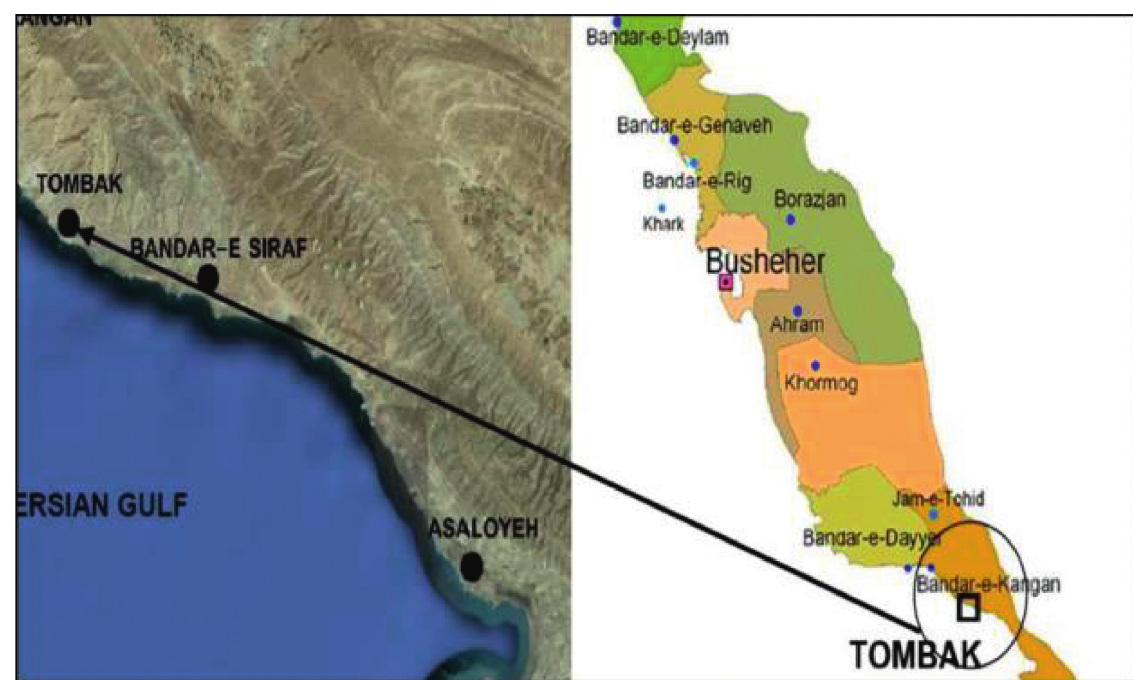
Figure 21: Location of Tombak port on the shores of the Persian